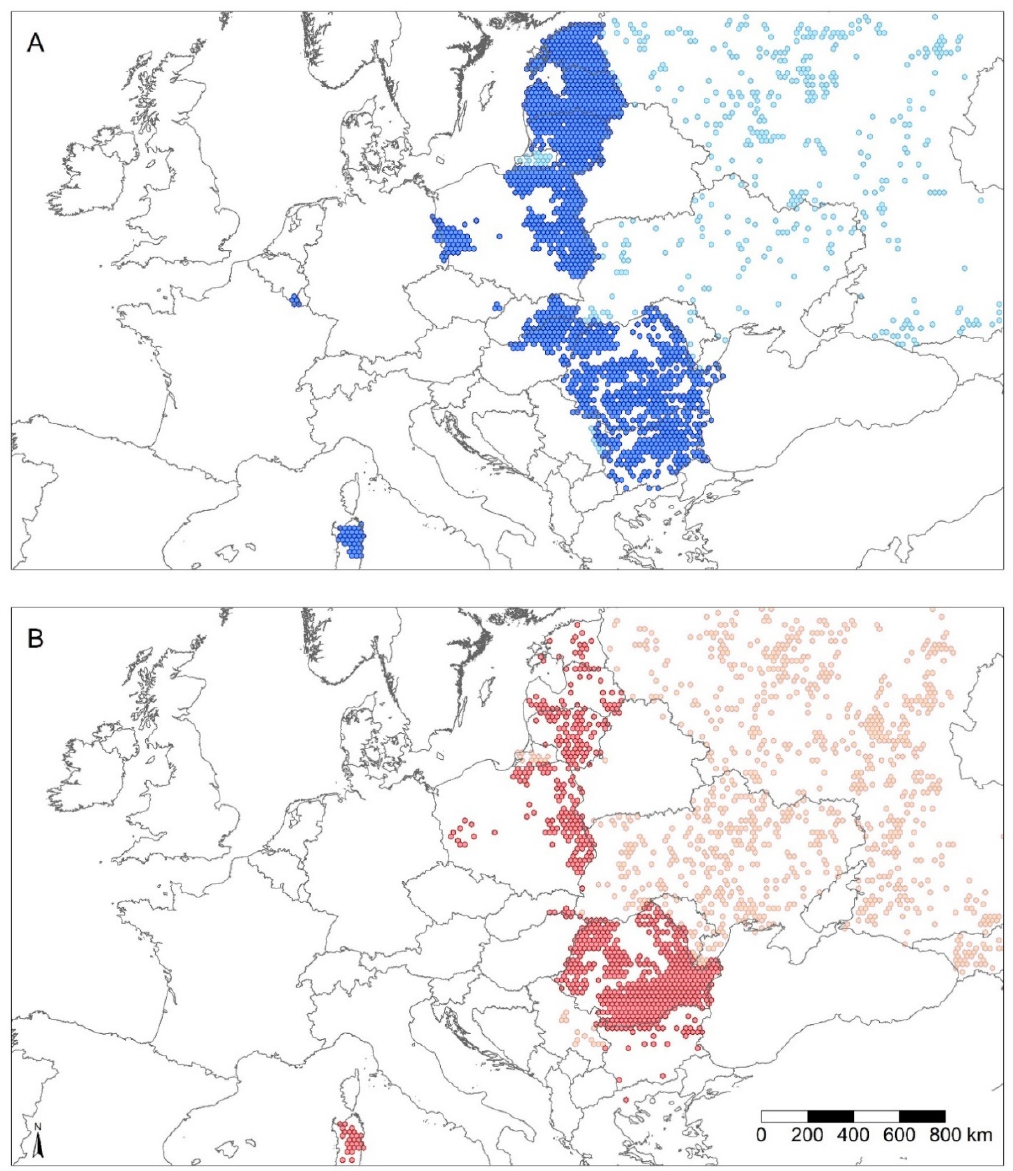
Figure 2. Area estimate maps of European countries affected by ASF in wild boar and domestic pigs. The maps show an estimate of the spatial extent of ASF in Europe, comparing ASF reports from April 2007 to May 2021 in wild boar ( A , blue), with reports in domestic pigs ( B , red) mapped to a 20 km hexagonal grid across the shown area. One 20 × 20 km grid cell covers an area of 346.41 km 2 . Grid cell regions with ASF reports in countries of the EU are marked by dark blue (wild boar, A ) or dark red colour (domestic pig, B ), whereas grid cell regions with ASF reports outside of EU countries are indicated by light blue ( A ) or light red colour ( B ), respectively. Clear areas of the map with no grid cells shown did not report ASF. The total number of ASF affected grid cells during the mapped time segment in all EU countries (dark cells only) was 1772 cells for ASF reports in wild boar ( A , total area of approximately 613,839 km 2 ) and 892 cells for ASF reports in domestic pigs ( B , total area of approximately 308,998 km 2 ). EU—European Union; ASF—African swine fever; Source: OIE, ADIS; Considered reports include the detection of ASFV genome (PCR) and humoral immune responses to ASFV (ELISA).